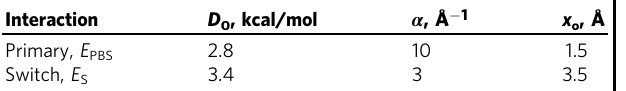
Table 1 Interaction parameters.